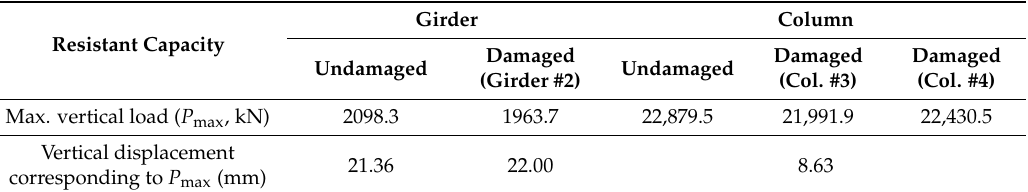
Table 3. Resistant capacity of target components obtained from numerical